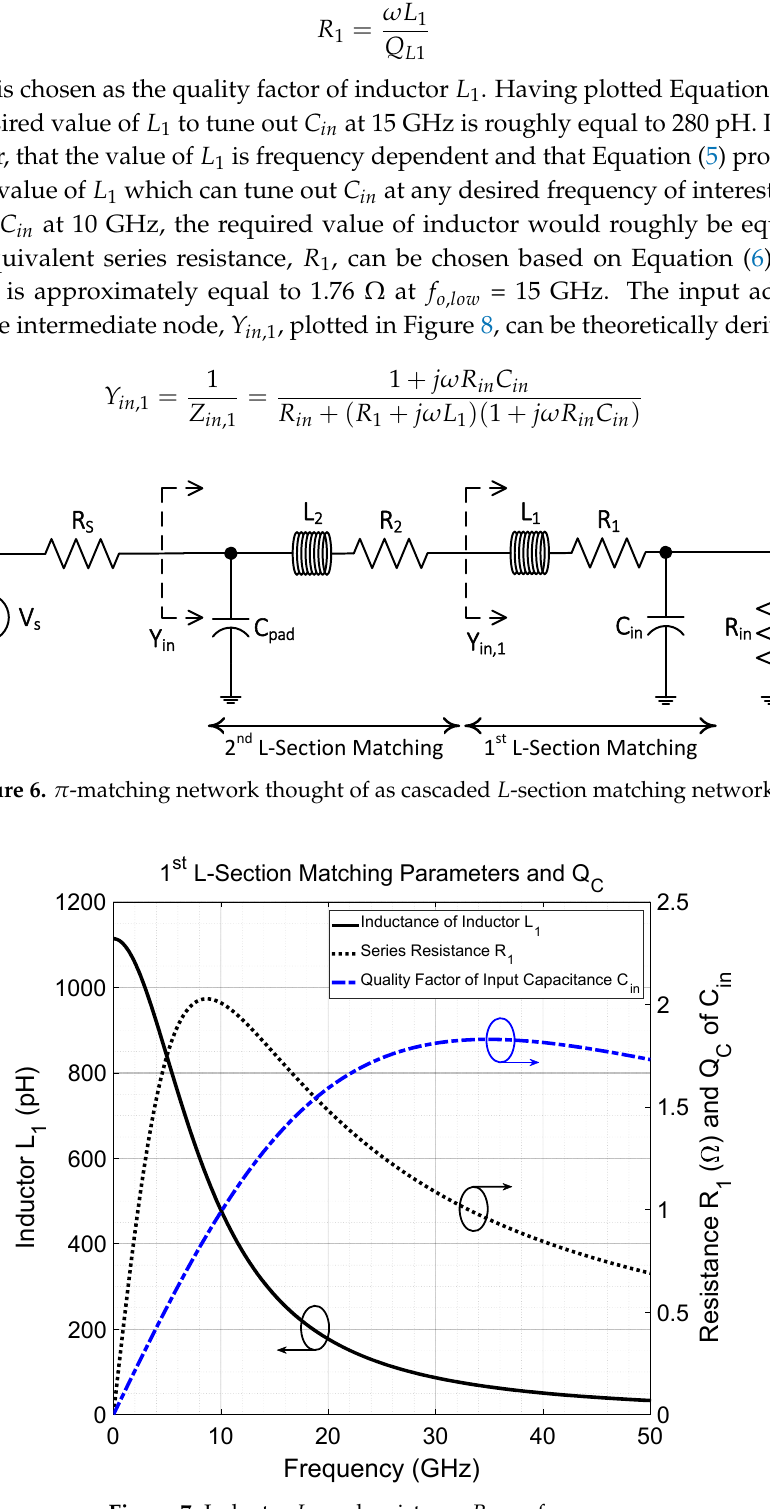
Figure 7. Inductor L 1 and resistance R 1 vs.